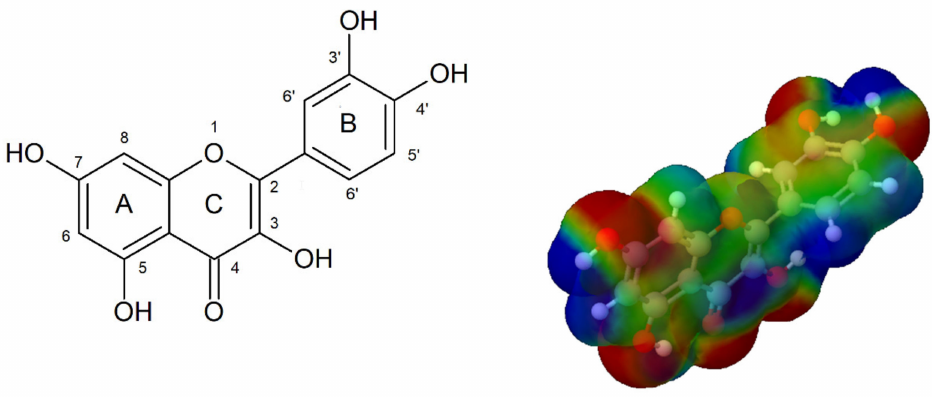
Figure 11. Quercetin structure and its molecular electrostatic potential (MEP)